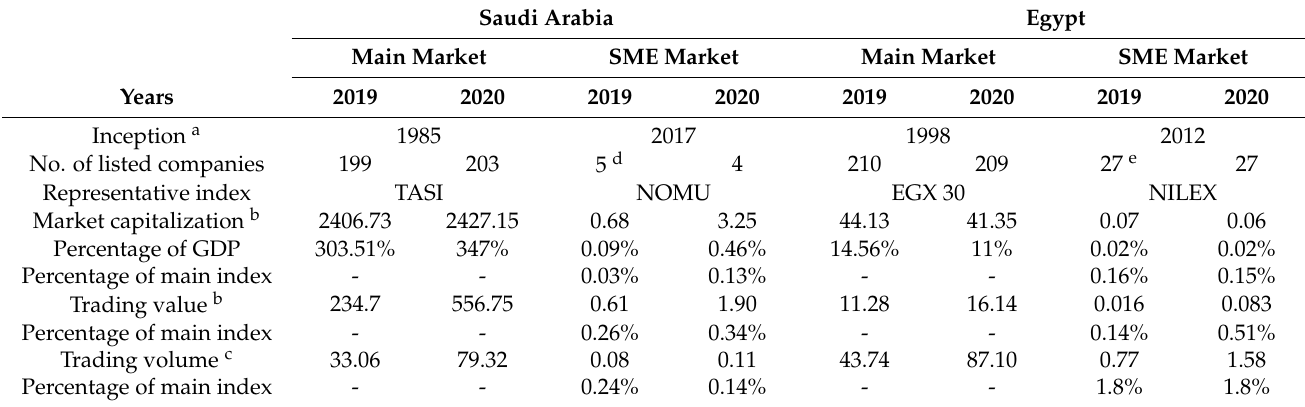
Table A1. Stock market characteristics.